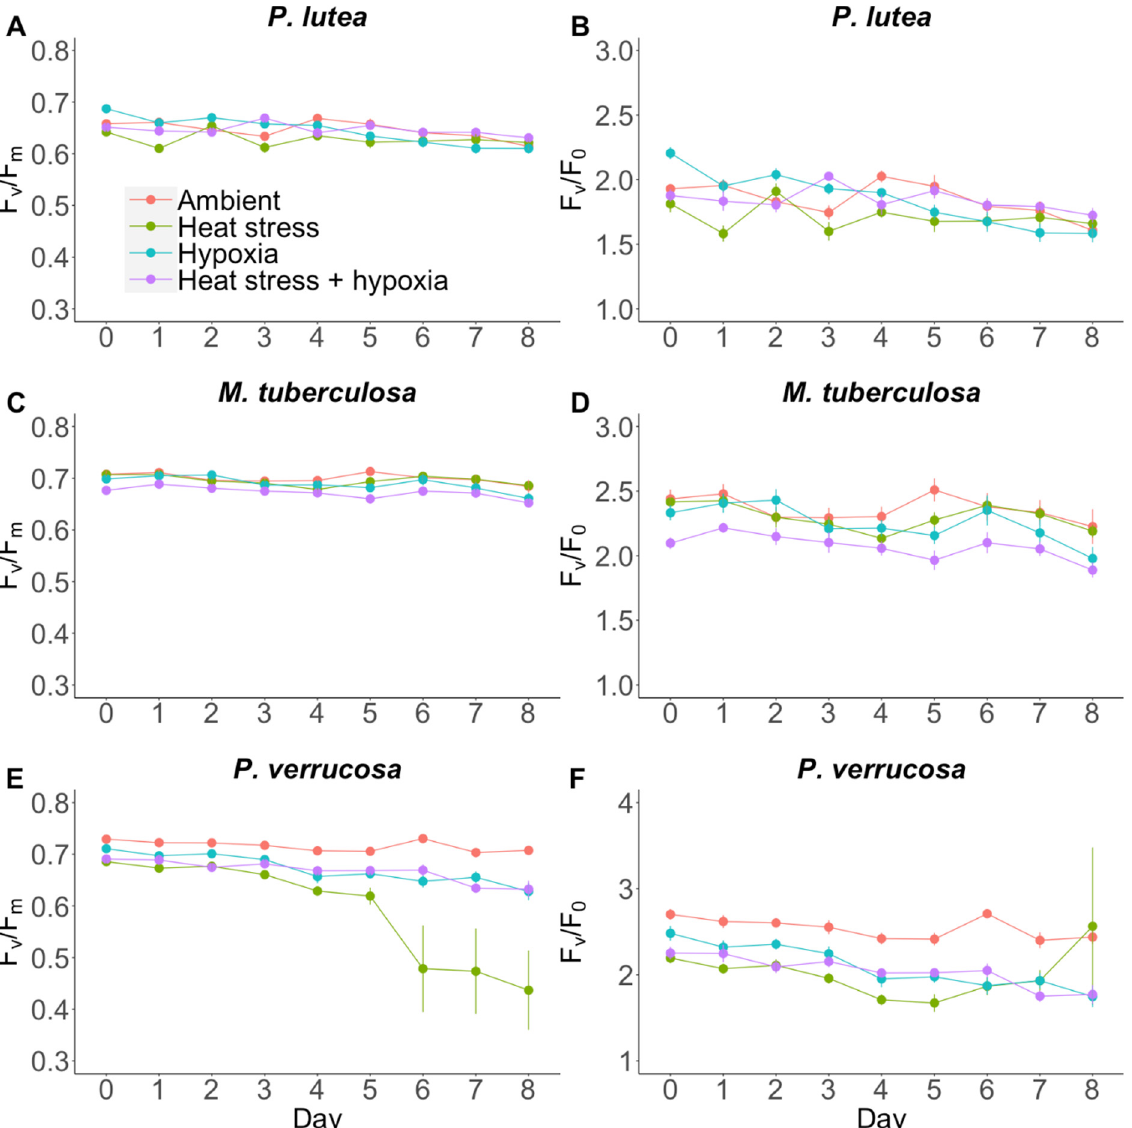
Figure 3. Maximum quantum yield of PSII (F v /F m ; left) and photochemical efficiency of PSII (F v /F 0 ; right) in P. lutea ( A , B ), M. tuberculosa ( C , D ), and P. verrucosa ( E , F ) measured after the light period. Data are shown as mean ± SE ( n = 4).